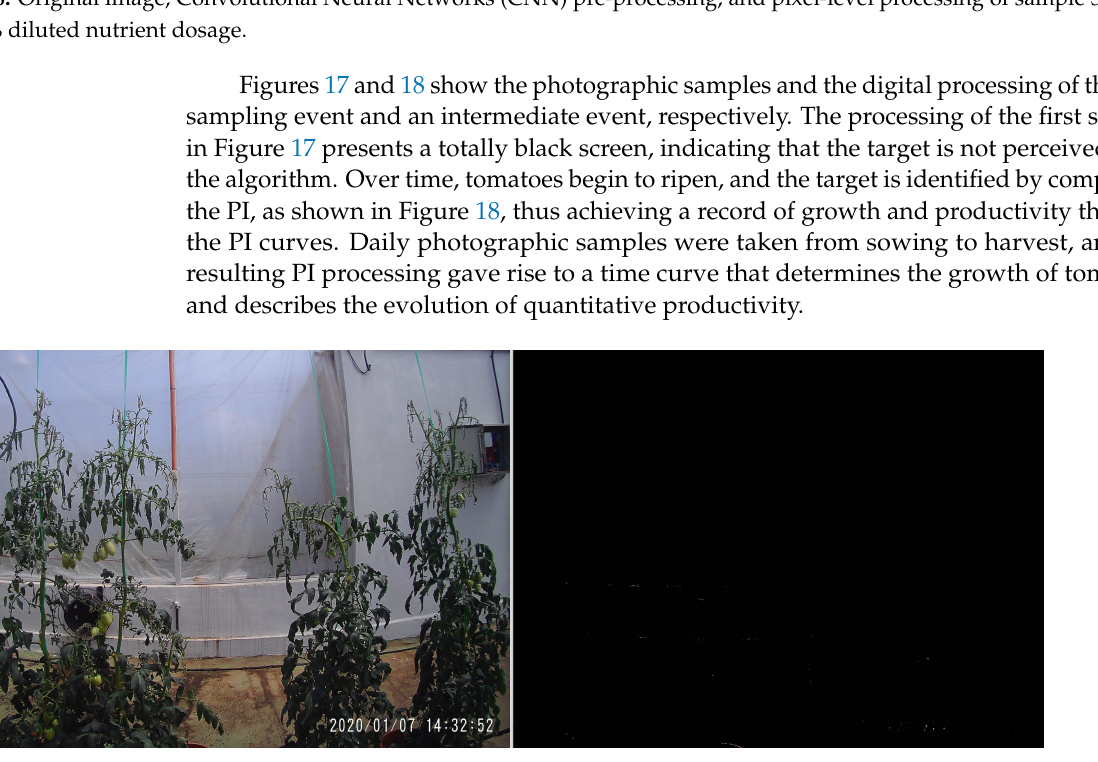
Figure 17. First photographic sample of the first sub plot with 50% of commercial nutritional solution and its digital Productivity Index (PI) processing with the date and time of the